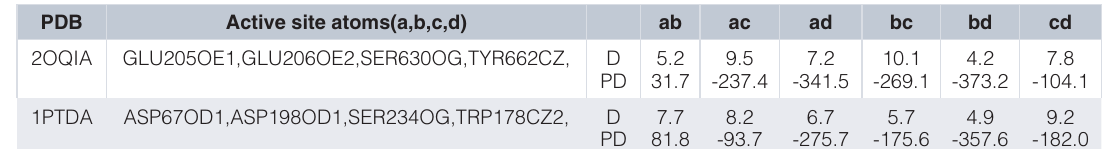
Table 6. Potential and spatial congruence of the residues binding vildagliptin in DPP4 structure (PDBid:2OQIA) to the putative binding site in PI-PLC structure (PDBid:1PTDA). Both the structures are apo enzymes, since the binding of a ligand induces spatial and electrostatic changes in the active site. Ser630 in DPP4 has a significant spatial difference as compared to Ser234 in PI-PLC (pair ‘bc’ has a difference of 5 Å), and also a reasonable electrostatic difference (pair ‘ac’ has a difference of 144 PD units). D = Pairwise distance in Å. PD = Pairwise potential difference. APBS writes out the electrostatic potential in dimensionless units of kT/e where k is Boltzmann’s constant, T is the temperature in K and e is the charge of an